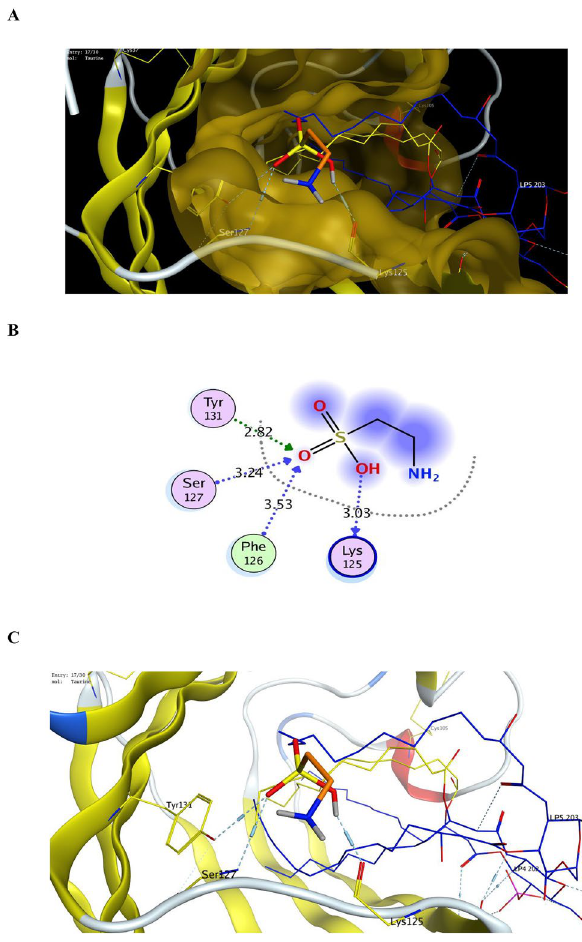
Figure 9. ( A ) Binding of Taurine (orange) inside the binding site of TLR4-MD2 complex (PDB code: 4G8A), (B) 2D binding mode of Taurine with binding site of TLR4-MD2 complex (PDB code: 4G8A), ( C ) 3D binding mode of Taurine with binding site of TLR4-MD2 complex (PDB code: